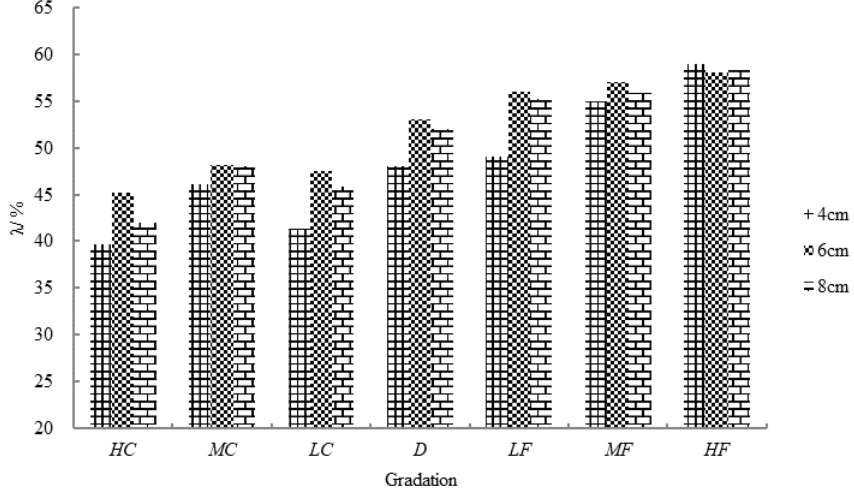
Figure 12. λ value of asphalt mixtures .